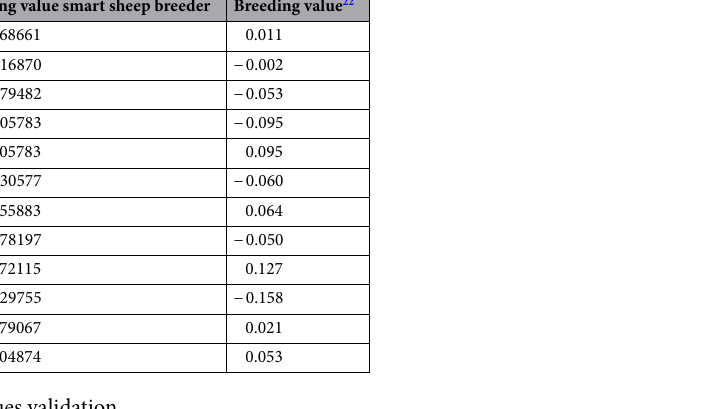
Table 1. Breeding values